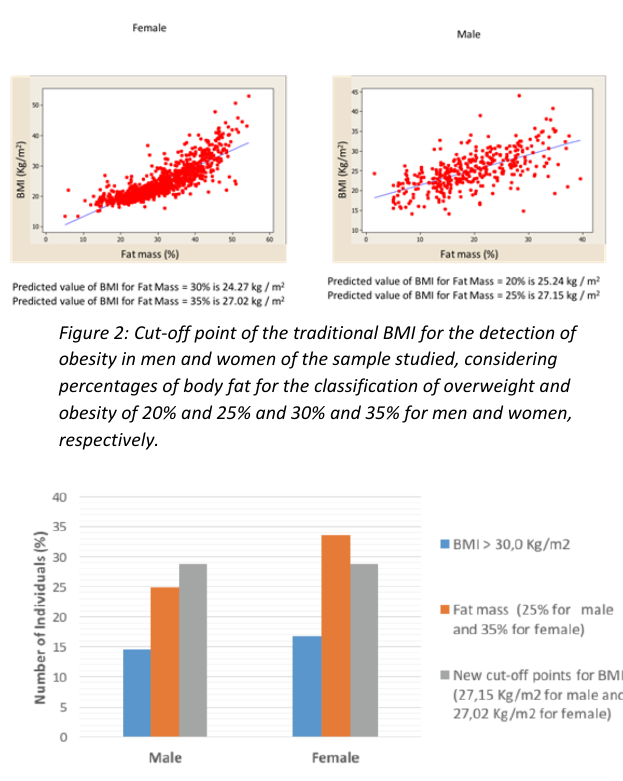
Figure 3: Number of individuals (%) classified as obese accordig to 3 different criteria: BMI higher than 30 kg/m 2 for men and women, fat mass (%) higher than 25% for men and 35% for women, and new cutoff points for the BMI of 27.15 kg/m 2 for men and 27.02 kg/m 2 for